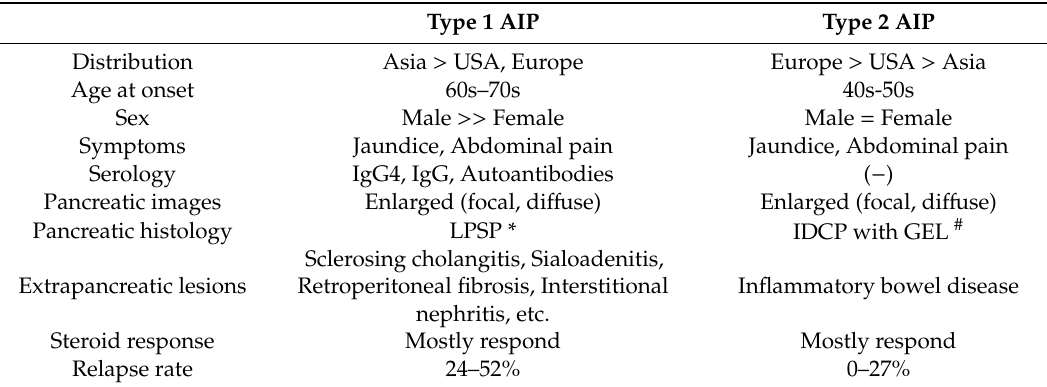
Table 1. Characteristics of type 1 and type 2